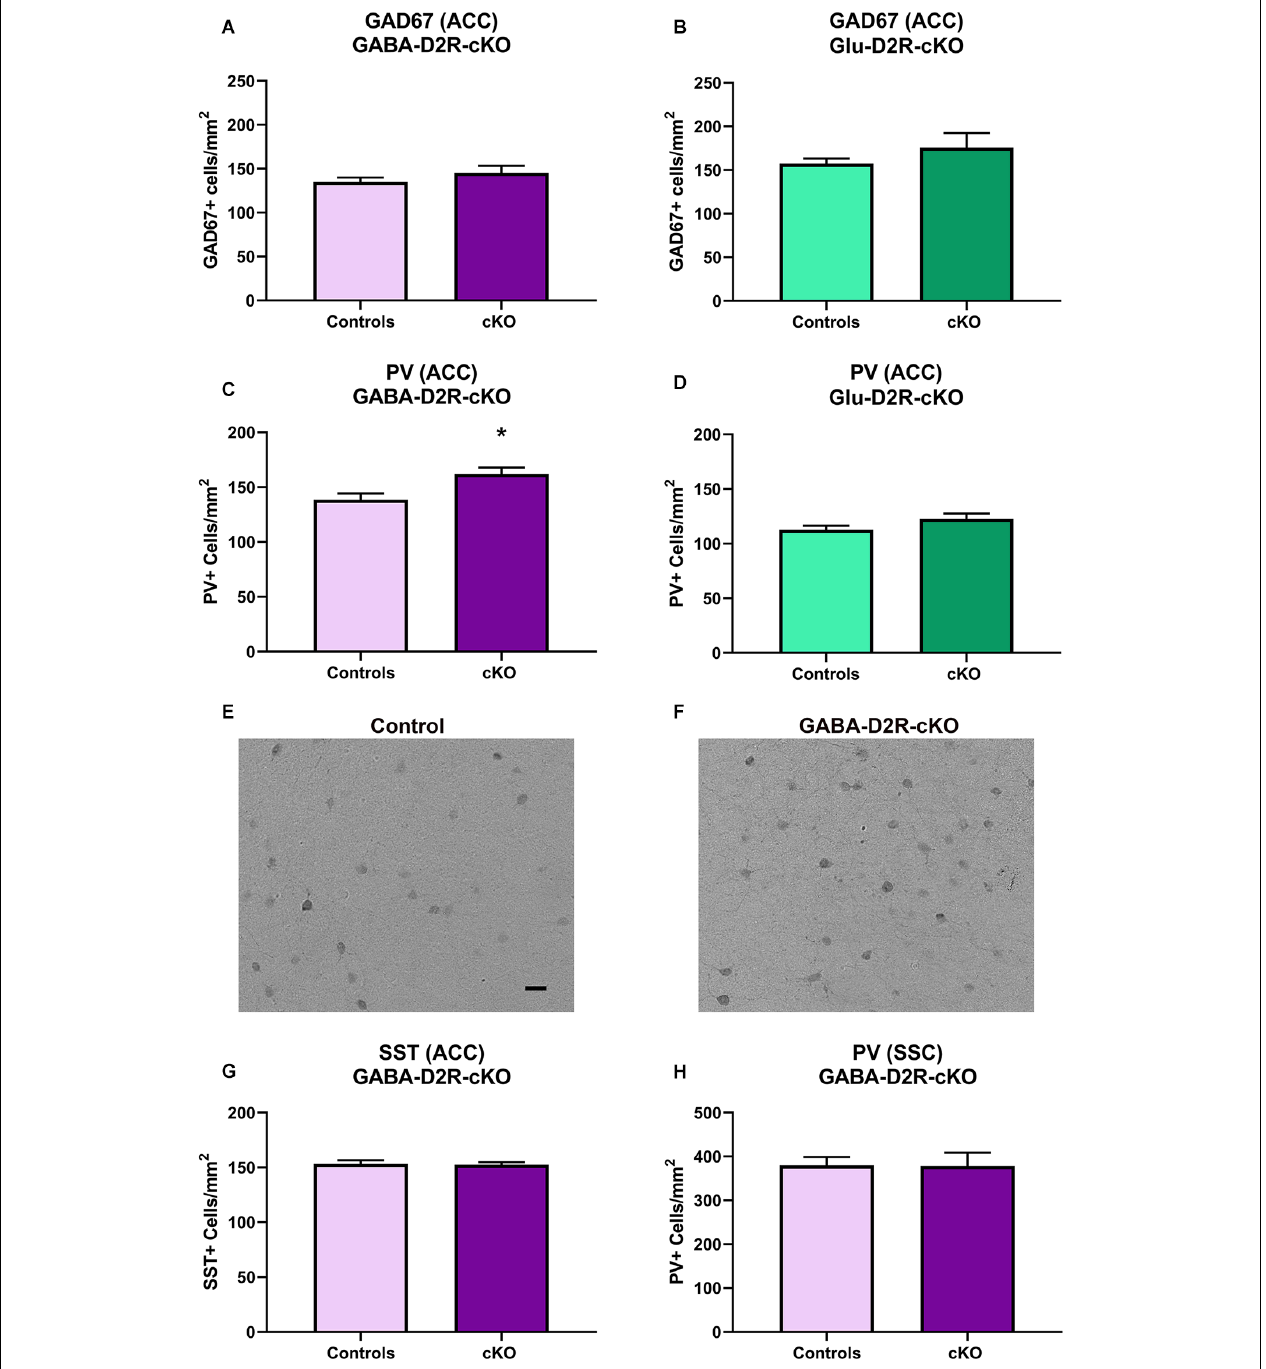
FIGURE 12 | Increased PV+ interneurons in GABA-D2R-cKO mice in the absence of changes in other markers or brain regions. The number of cortical GAD67+ neurons did not differ in either GABA-D2R-cKO (A) or Glu-D2R-cKO (B) mice. On the contrary, PV+ interneurons within the ACC were significantly elevated in GABA-D2R-cKO (C,F) compared to controls (E) , but no change was apparent in Glu-D2R-cKO (D) mice. This effect was specific to this marker within this region, as neither SST numbers (G) nor PV+ interneurons within the DA-poor SSC region (H) changed. * p < 0.05 as compared to control by post hoc comparison.